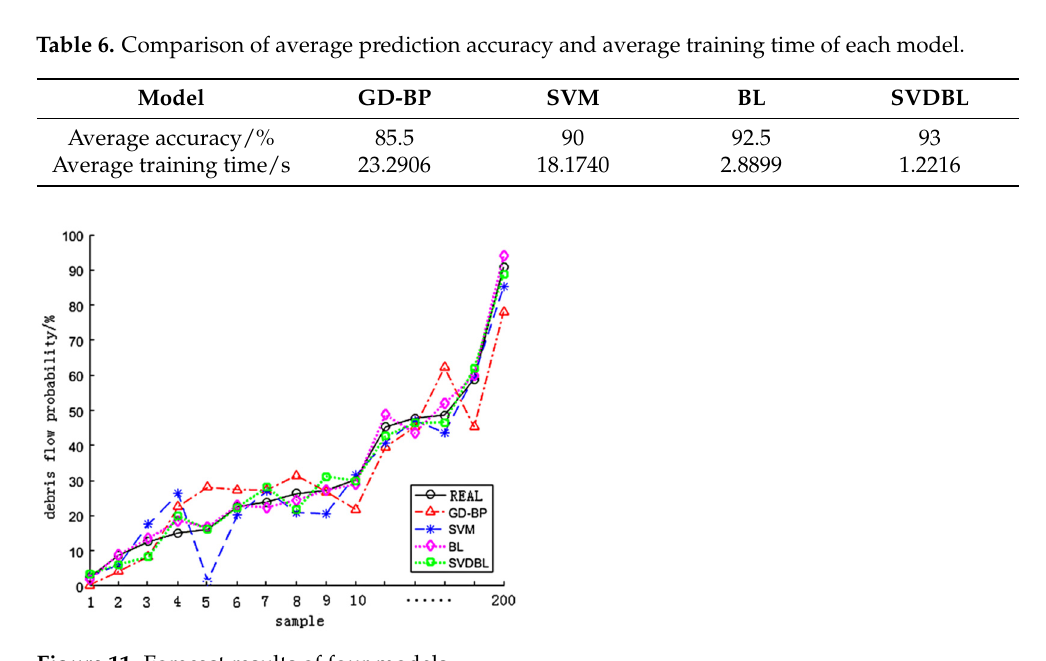
Table 6. Comparison of average prediction accuracy and average training time of each model.